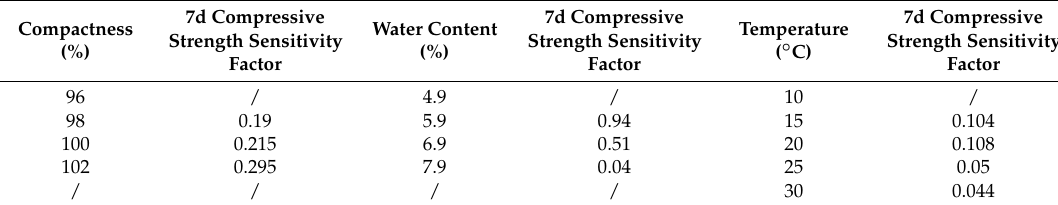
Table 2. Sensitivity factors for various